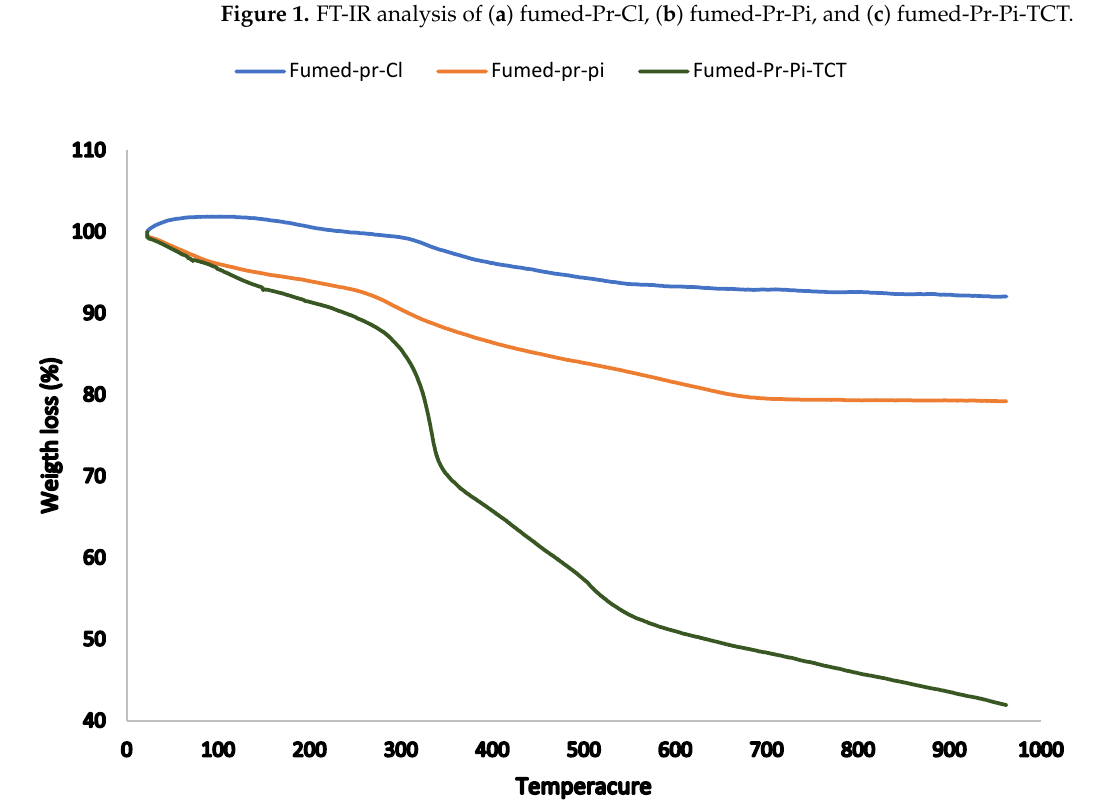
Figure 2. TGA curves of fumed-Pr-Cl, fumed-Pr-Pi, and fumed-Pr-Pi-TCT.